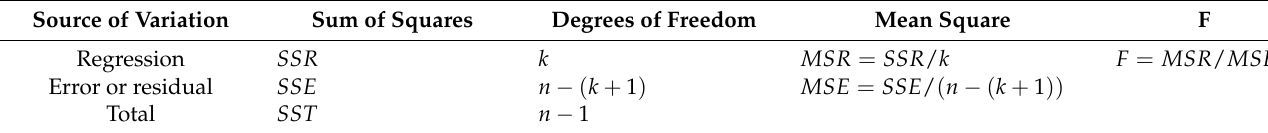
Table 3. Analysis of variance for significance of regression in multiple regression [38]. Source of Variation Sum of Squares Degrees of Freedom Mean Square F Regression SSR k Error or residual SSE